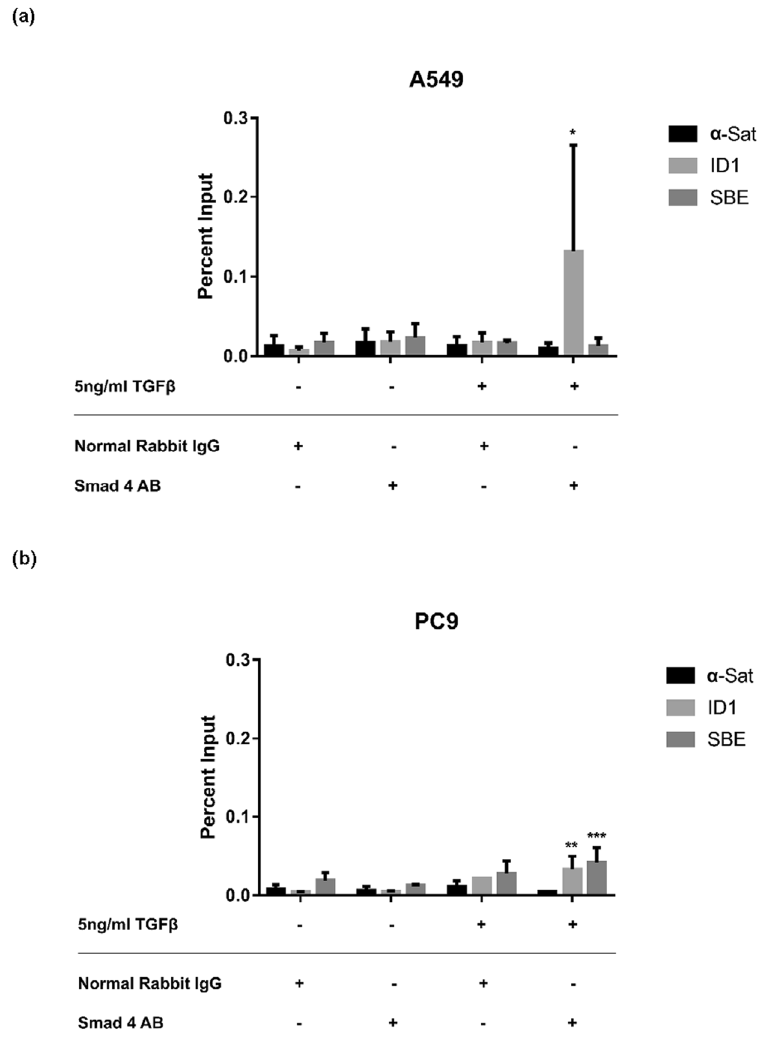
Figure 3. TGF β induces Smad4 binding to SBEs in the promoter of mir-200/141 in PC9 cells. Chromatin immunoprecipitation was performed to identify whether a physical interaction between Smad4 and a predicted SBE locus in the shared promoter of mir-200c/-141 resulted from TGF β treatment. Normal rabbit IgG served as the antibody negative control and α -Satellite primers as the negative PCR control. ID1 locus immunoprecipitation was the positive control for Smad4 binding. ( a ) In A549, positive Smad4-ID1 association is observed with TGF β treatment, but an Smad4-SBE interaction is not. ( b ) In PC9, both Smad4-ID1 and Smad4-SBE interaction is observed. Significance was calculated using an unpaired t-test comparing TGF β - treated cells and -untreated samples with the same primer